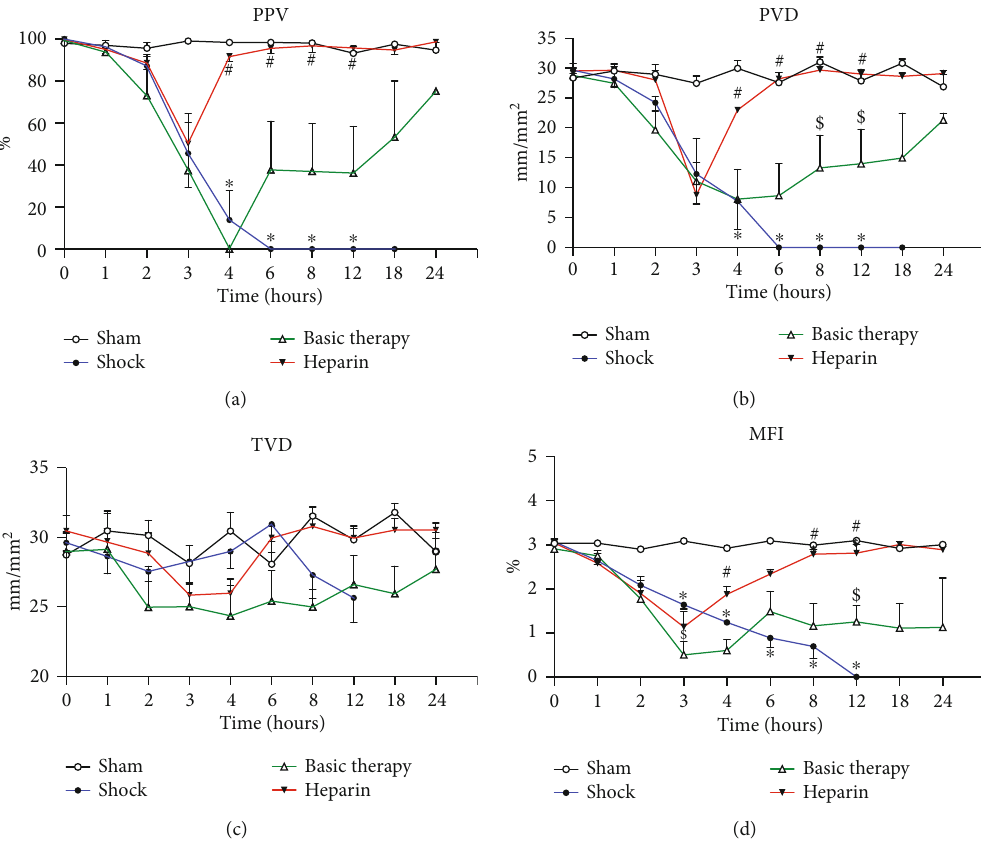
Figure 2: The dynamic changes of microcirculation in septic shock. The microcirculatory parameters including PPV, PVD, TVD, and MFI were monitored over 24 h and compared in the four groups. ∗ P < 0 : 05 : shock vs. sham group; # P < 0 : 05 : heparin vs. basic therapy group; $ P < 0 : 05 : shock vs. basic therapy